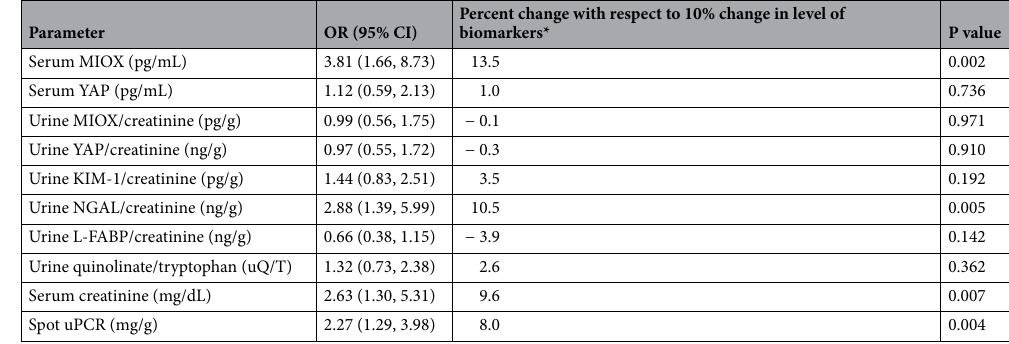
Table 4. Adjusted logistic regression of serum and urine biomarkers at hospital discharge for the association of renal outcome (progression to CKD from CA-AKI). Adjusted variables included age, sex, q-SOFA score, comorbidities (diabetes and hypertension), KRT and duration of hospitalization. uPCR urine protein creatinine ratio, MIOX myo-inositol oxygenase, YAP Yes-associated protein, KIM-1 kidney injury molecule-1. NGAL neutrophil gelatinase-associated lipocalin, L-FABP liver-type fatty acid binding protein. *Percentage change with respect to 10% change in levels of biomarkers, is represented as these variables are standardized log transformed. It was computed from odds ratio (OR) by formula; 100 × (exp(log(OR) × log(1.1)) − 1).